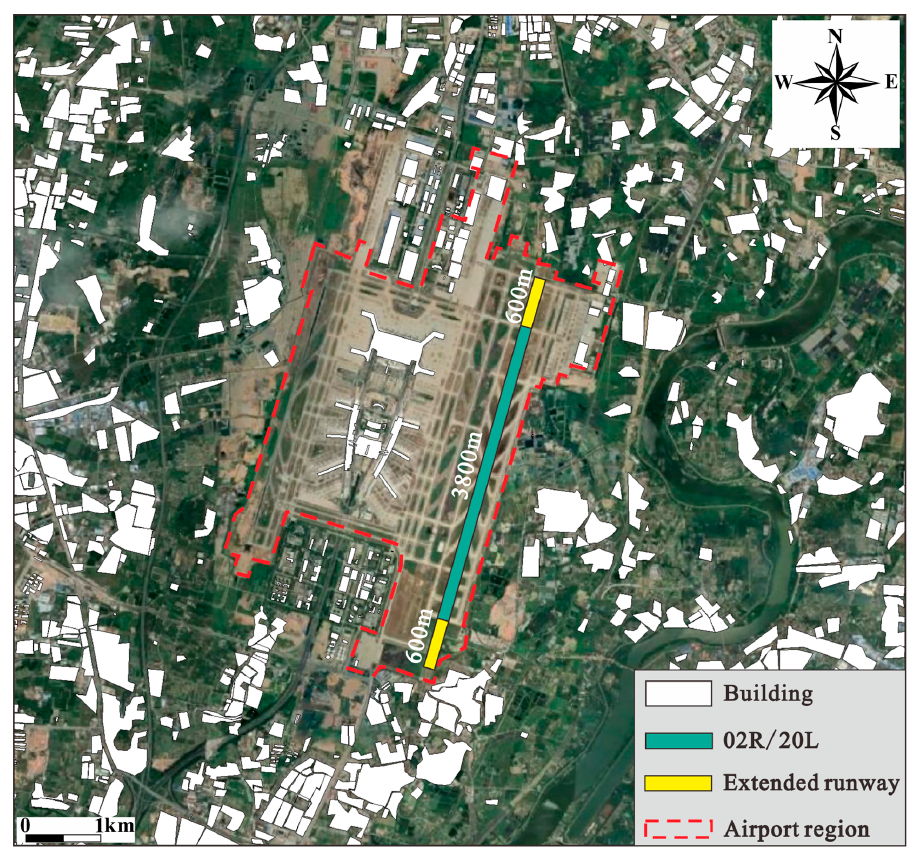
Figure 9. The proposed modification of the operating runway 02R/20L. It should be noted that the lengths of these modified operating runways are still 3800 m, meaning the operating runways 20L/02R are overall moved 600 m to the south and north directions during summer and winter, respectively. As shown in Figures 10 and 11, it is obvious that by moving the runways in summer and winter, the areas covered by the noise profiles of higher noise levels such as L WECPN = 85 dB and 90 dB are reduced signif- icantly at the end of the landing zone (white circles). Consequently, the population ex- posed to high noise levels decreases significantly, as tabulated in Table 5. For instance, the exposed population in the area with L WECPN > 85 dB decreases by 32.17% and 49.22% dur- ing summer and winter, respectively. In addition, no more people are exposed to noise levels higher than 90 dB. It is worth mentioning that although the non-landing zones (black circles) of the new runways (20LN / 02RN) are closer to the residential buildings, the simulation results show that the noise profiles of the non-landing zones do not change significantly. This is because the taxiing distance required for an aircraft to land is always shorter than the length of the runway [32], so no aircraft is taxiing at the end of the non- landing zone. Figure 12 clearly indicates that the modification of the operating runway is more effective at alleviating unfavorable effects on the population that suffers under a high noise level (i.e., L WECPN > 85dB). Hence, the application of such an approach would be superior when the population is dense at the near end of the landing zone.